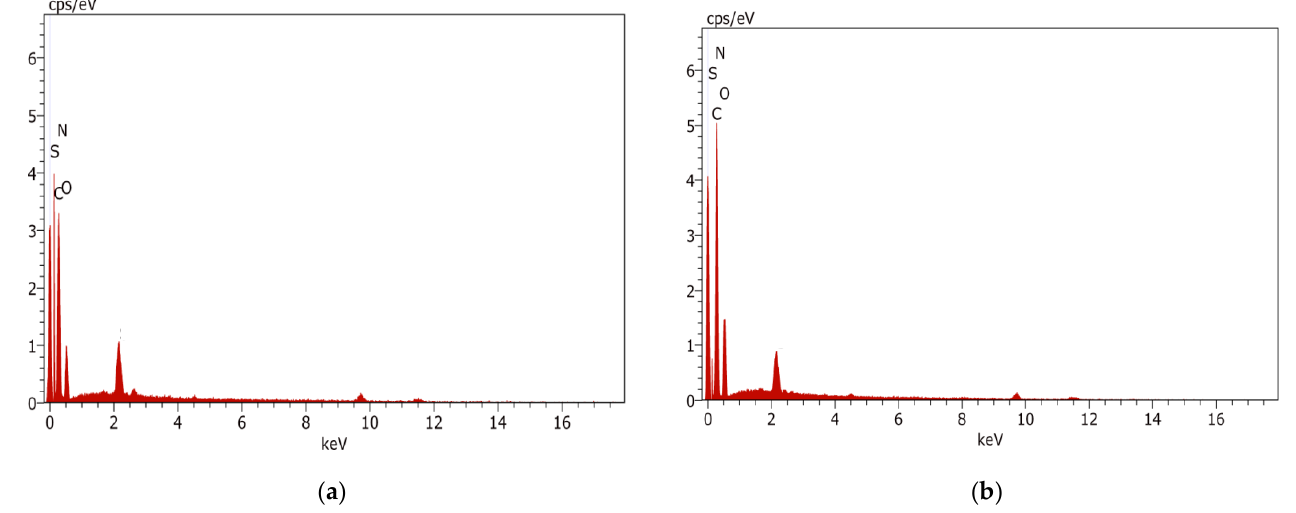
Figure 10. ( a ) EDX analysis of the TFC membranes, ( b ) EDX analysis of the 0.05-GQD/PA TFN membrane. Table 3. Elemental compositional analysis of the TFC and 0.05-GQD/PA TFN membranes.